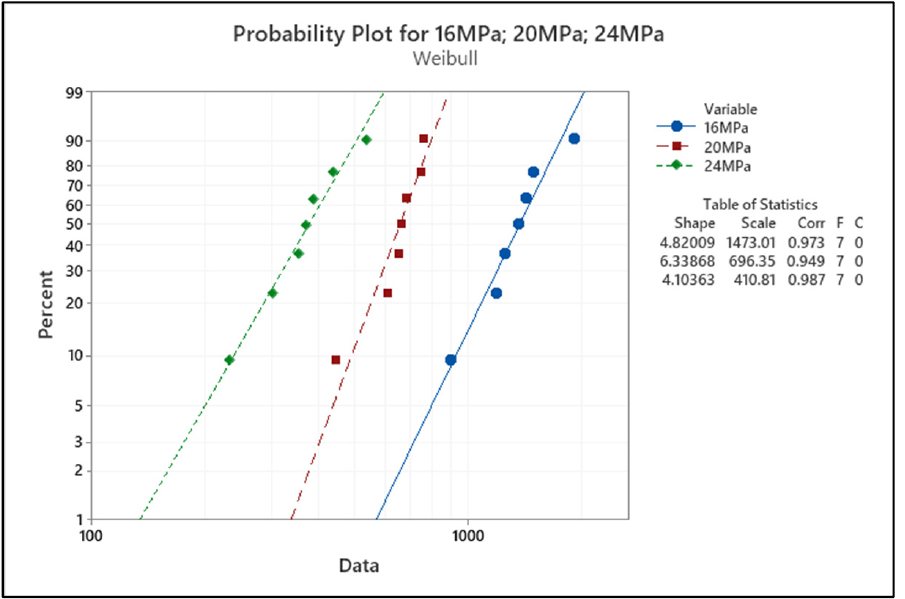
Figure 5. Weibull probability plot for SAC305 solder joints at 25 °C operating temperature and dif-